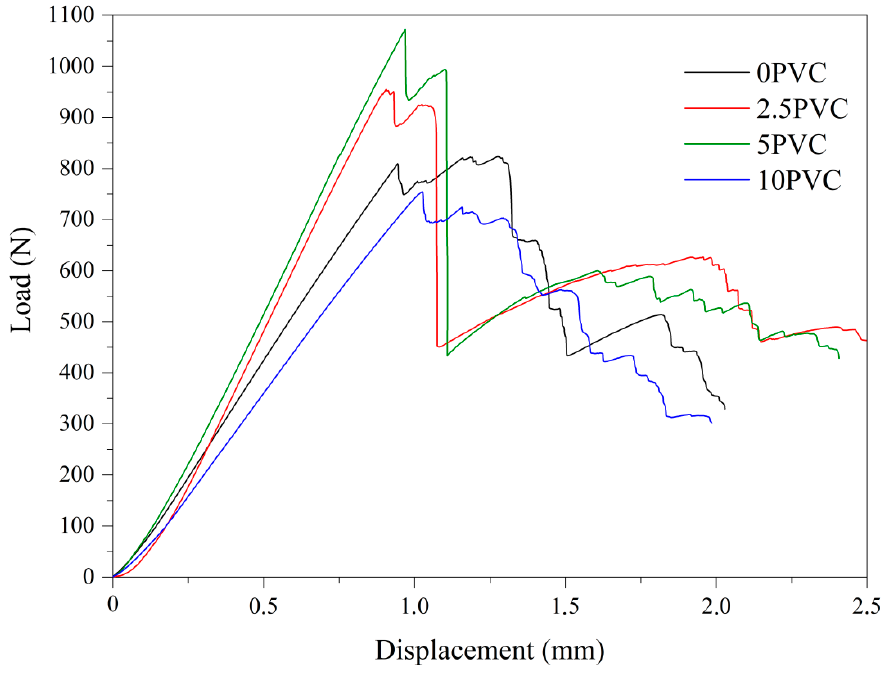
Figure 5. The curves of load on displacement for investigated materials.